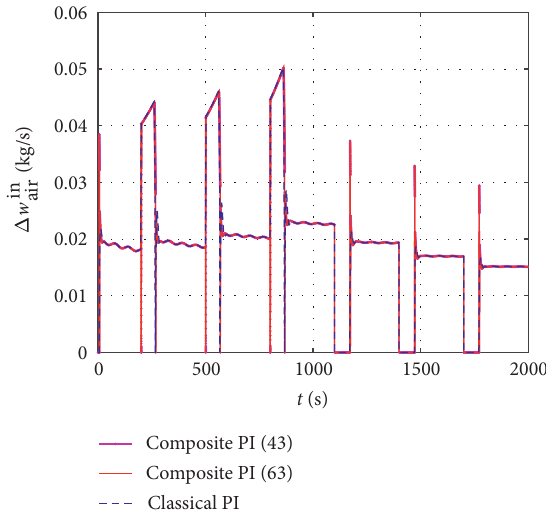
Figure 7: The profiles of the additional air mass flows by classical PI and composite PI ((37) and